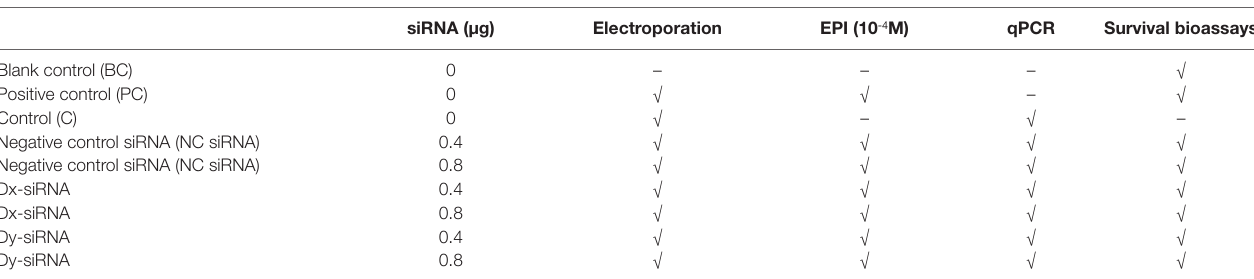
TABLE 1 | The experimental